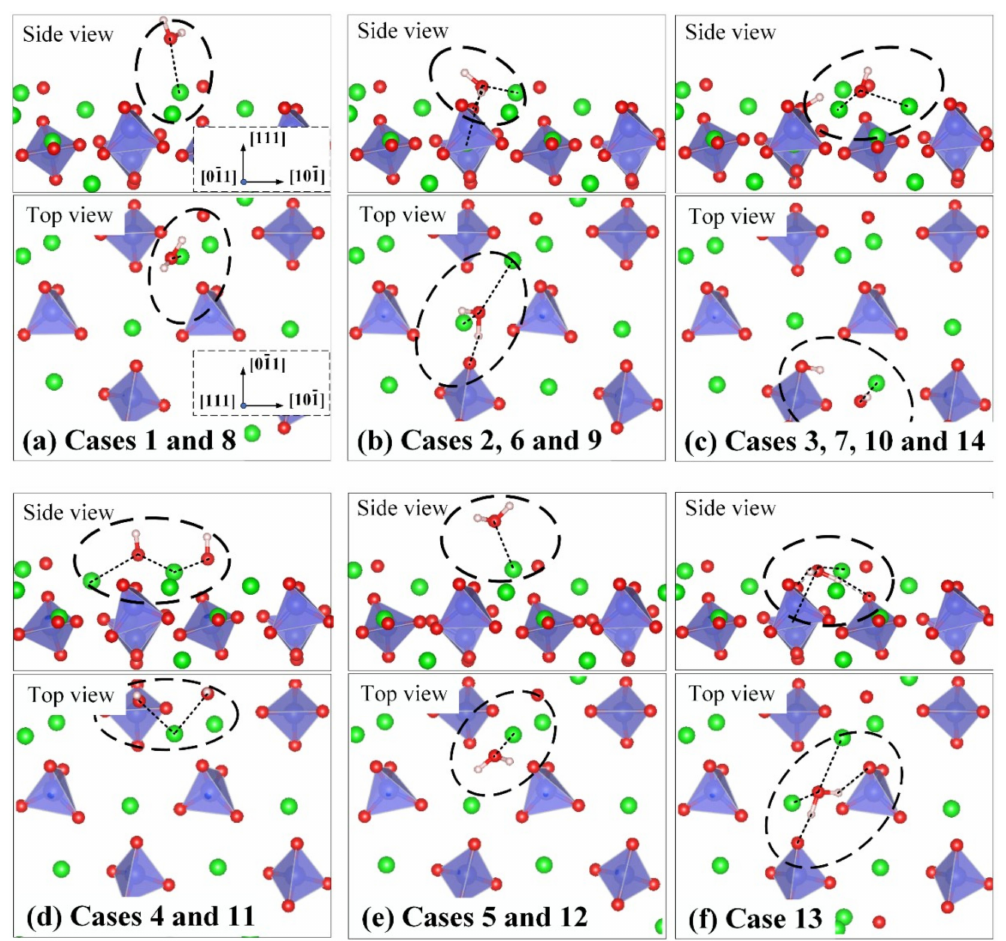
Figure 5. Adsorption configurations of a water molecule on the M3-C 3 S (111)